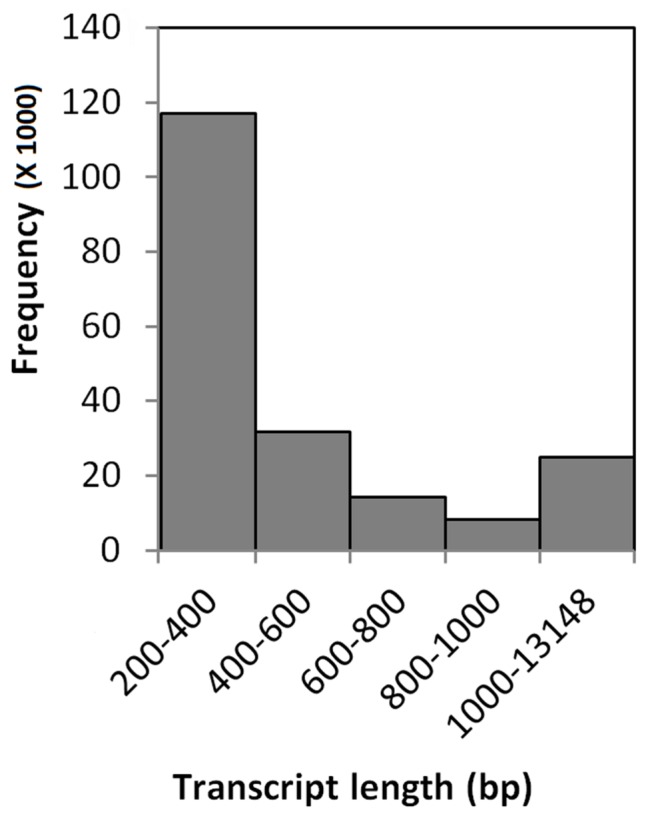
Transcript length frequency distribution of the final buffalograss reference transcriptome, consisting of 196168 transcripts.